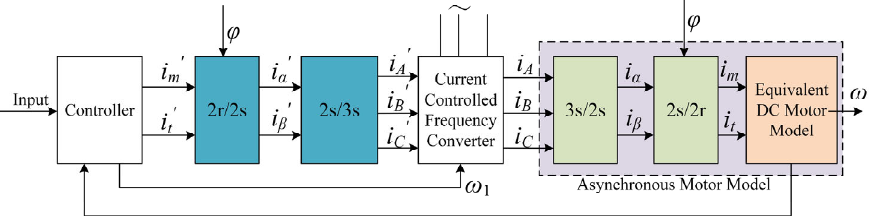
Figure 7. The principle of vector control [22].